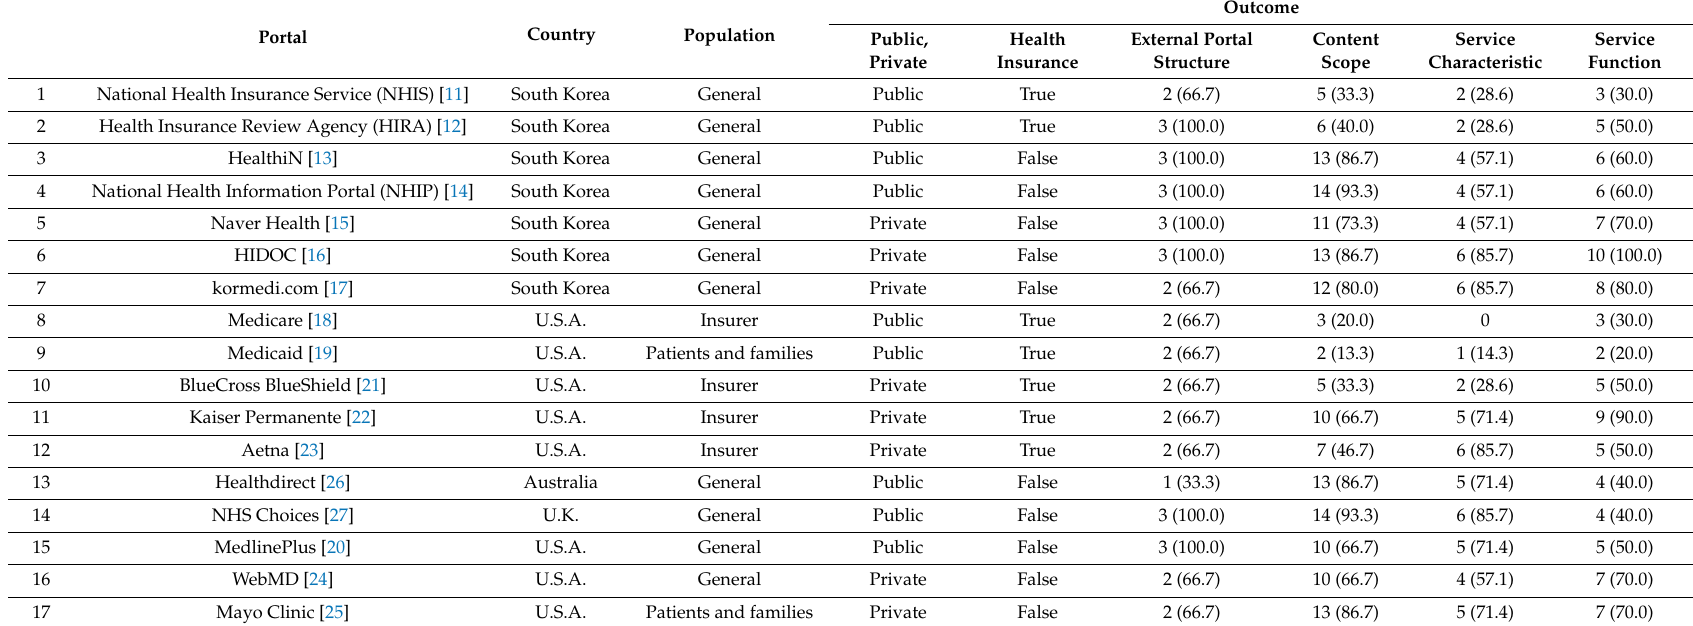
Table 1. Characteristics of the selected